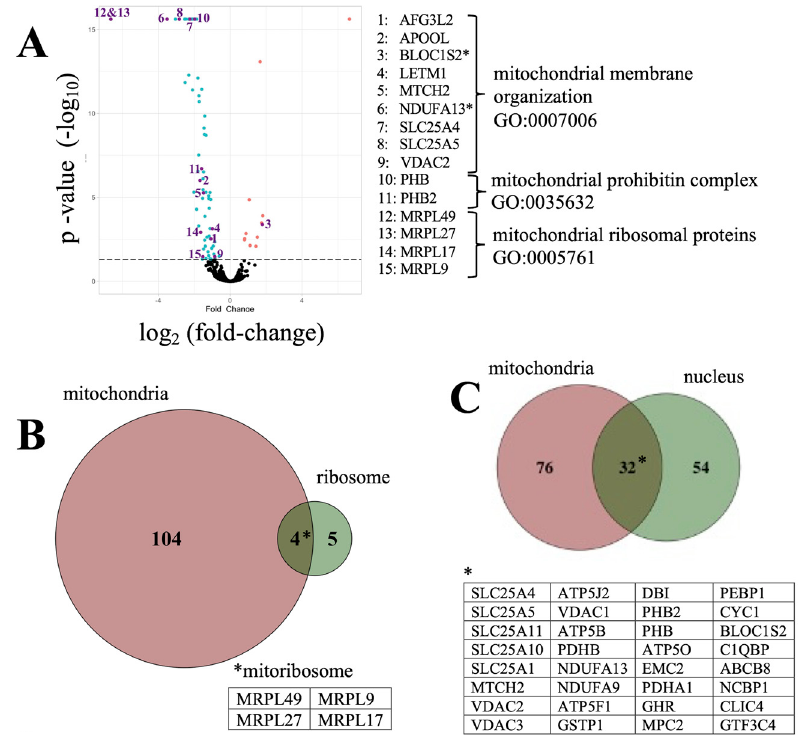
Figure 5. Mitochondrial subcomponents of the A β 42 proteome. ( A ) the distribution of significantly altered proteins within A β 42 proteome showing impacted subcomponents of mitochondrial organi- zation and function according to GO analysis. The dotted line indicates the threshold to statistical significance ( − log 10 p -value). Green: 95 decreased proteins; red: 13 increased proteins. ( B ) the extent of mitochondria localized ribosomal proteins (mitoribosome) within A β 42 proteome. ( C ) overlap between nuclear and mitochondrial proteins in the A β 42 proteome. * mitoribosome